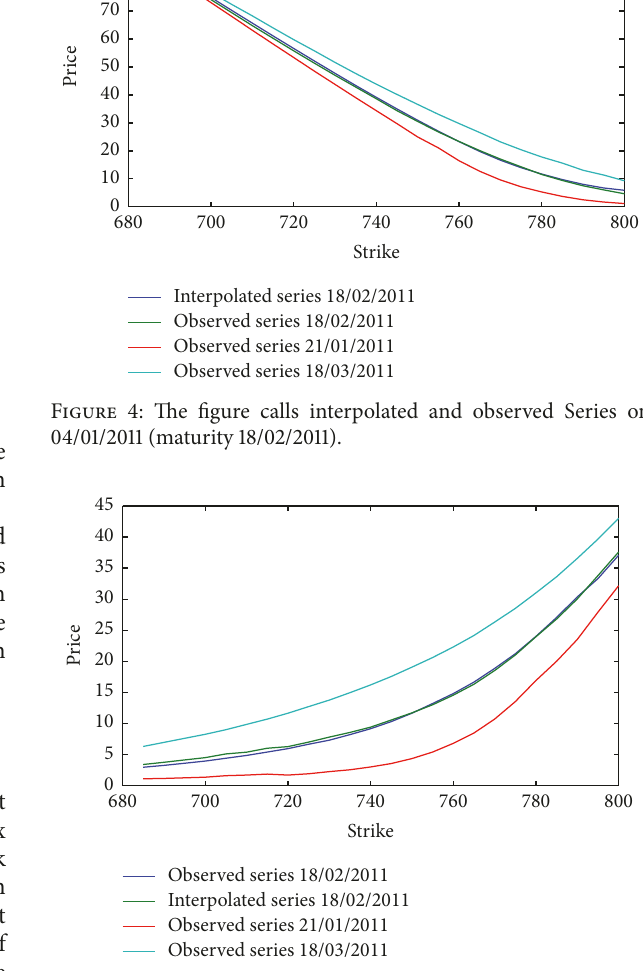
Figure 5: The figure puts interpolated and observed Series on 04/01/2011 (maturity